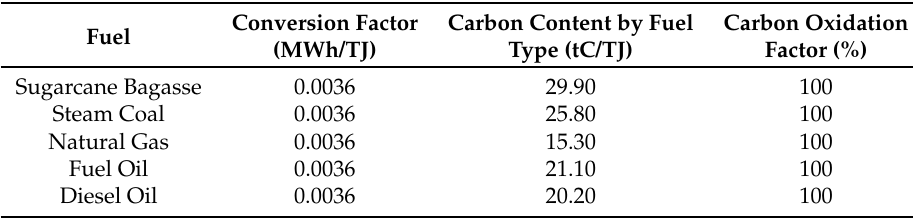
Table 9. Fuel characteristics of thermoelectric plants.